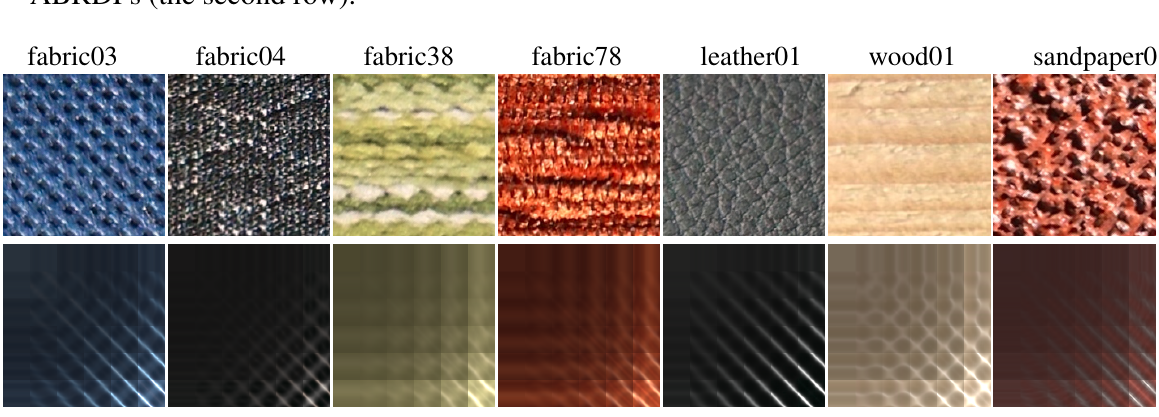
Figure 5. The measured materials on an area of 15 × 15 mm (the first row) and their average ABRDFs (the second row).